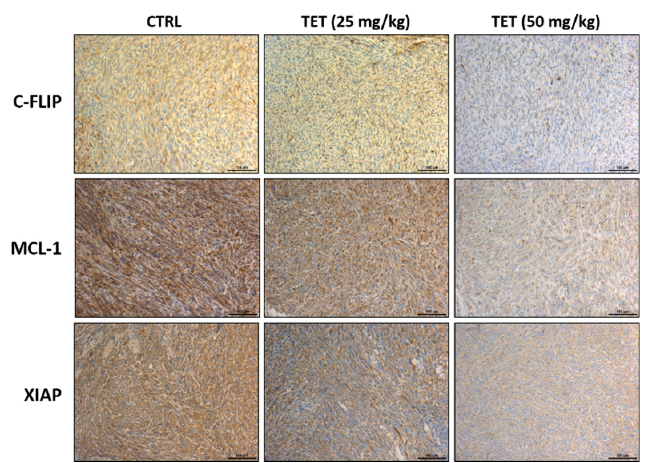
Figure 5. TET inhibited the levels of anti-apoptosis-related proteins. Tumors were isolated from each group and further examined by IHC staining. The IHC staining images of c-FLIP, MCL-1, and XIAP were observed under a microscope with 100 times magnification. All processes were described in Materials and Methods. Scale bar = 100 μ m.